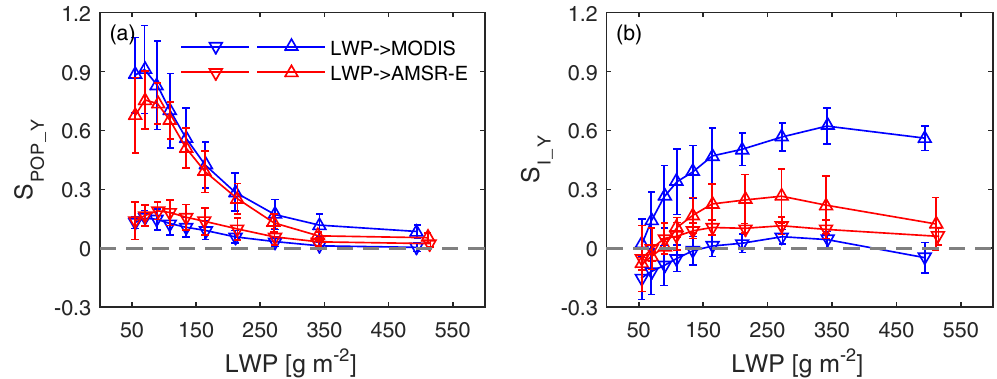
Figure 5. (a) S POP_Y and (b) S I_Y as a function of LWP. The subscript Y denotes different aerosol proxies corresponding to AI (downward triangles) and CDNC (upward triangles). Blue (red) represents LWP derived from MODIS (AMSR-E). The rain product used is the same as that in Fig. 1. AI and CDNC are estimated from MYD04 and MYD06,